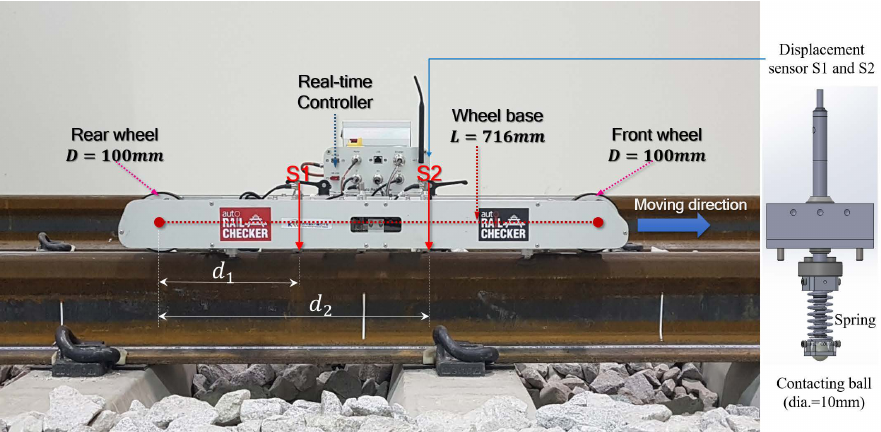
Figure 7. Auto Rail Checker (ARCer) with two displacement sensors and the detailed structure of the sensor; S1 and S2 are the position of the first and second sensor (Adapted and modified from